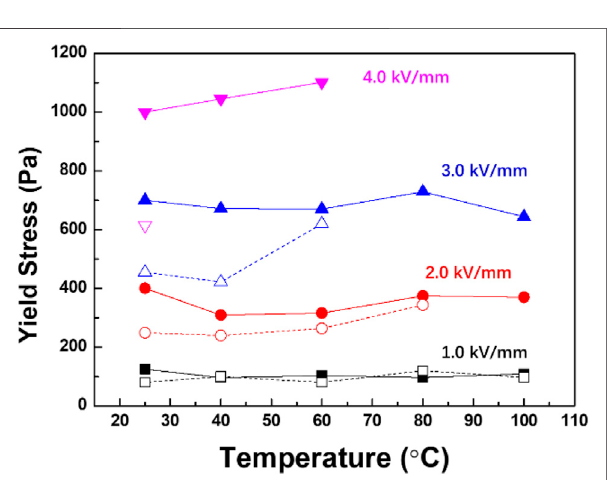
FIGURE8| YieldstressoftheER fl uids ofPIL(open)and PIL/TiO 2 (solid) as a function of temperature at different electric fi eld strengths.